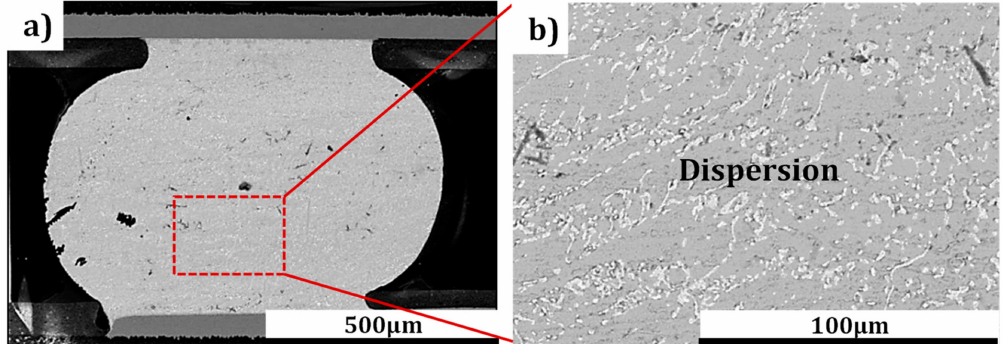
Figure 7. ( a ) and ( b ) are SEM images of the SnPb (Pb content is 22.46%) stored at CT ( − 196 ◦ C) for 10 days without current